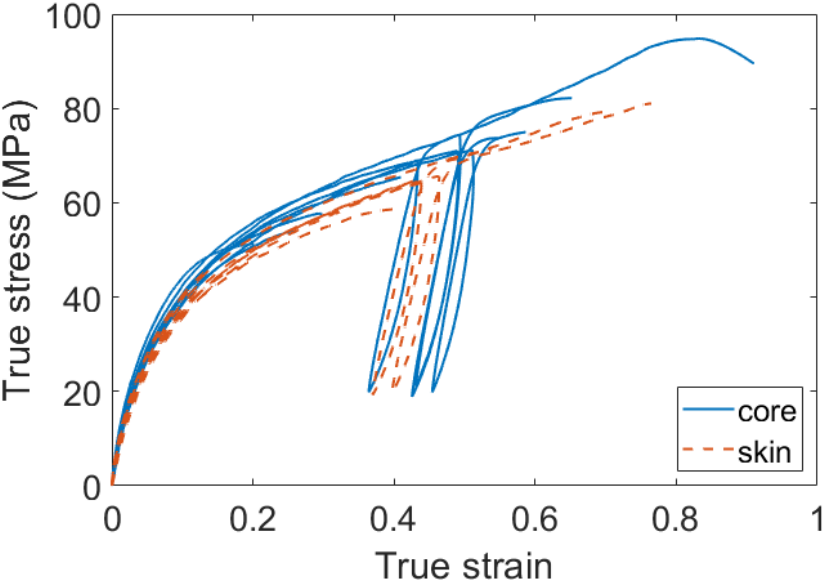
Figure 18. Illustration of the gradient of stiffness between the core and the skin material. Two curves are displayed for every aging condition: one for the core and one for the skin.